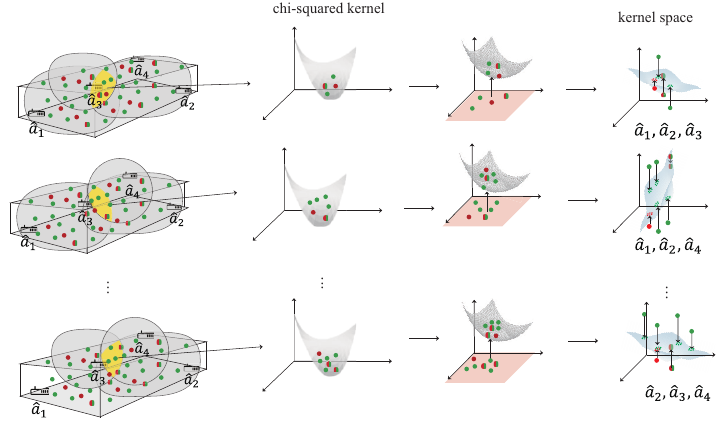
Figure 8. The multi-kernel construction phase. The pseudo code of the multi-kernel construction phase is shown in Algorithm 1. Algorithm 1: The multi-kernel construction